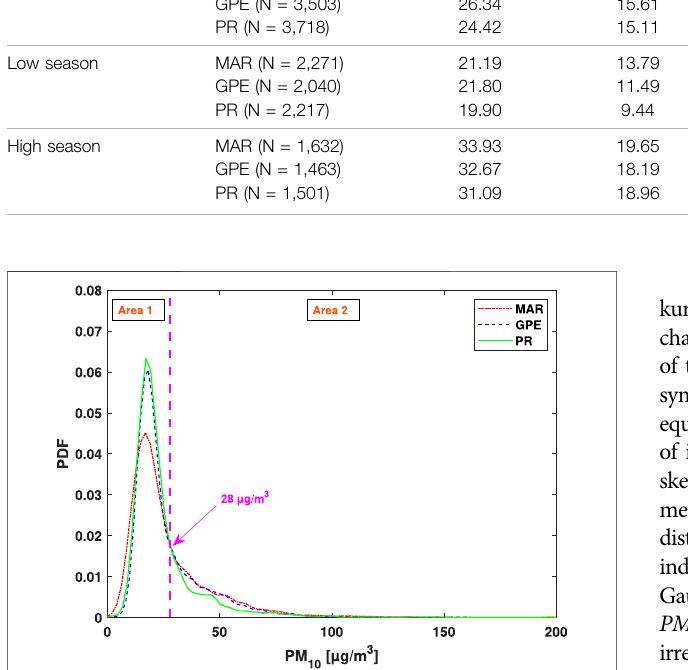
FIGURE4| ProbabilityDensityFunction(PDF)of PM 10 concentrationsat Martinique (MAR), Guadeloupe (GPE) and Puerto-Rico (PR) from 2006 to 2016. The vertical purple dashed line indicates a point where all the distributions